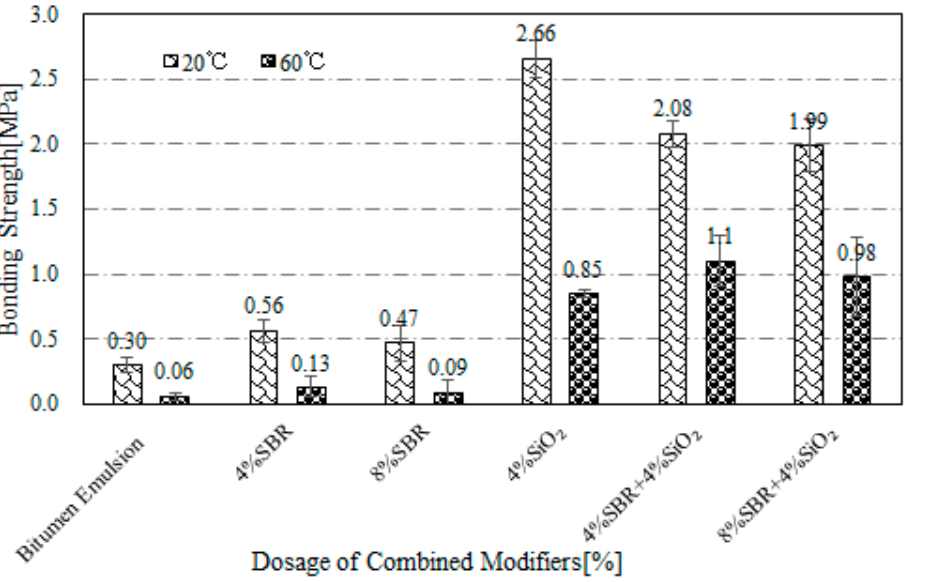
Figure 5. Bonding strength of SBR + SiO 2 -modified bitumen emulsion.